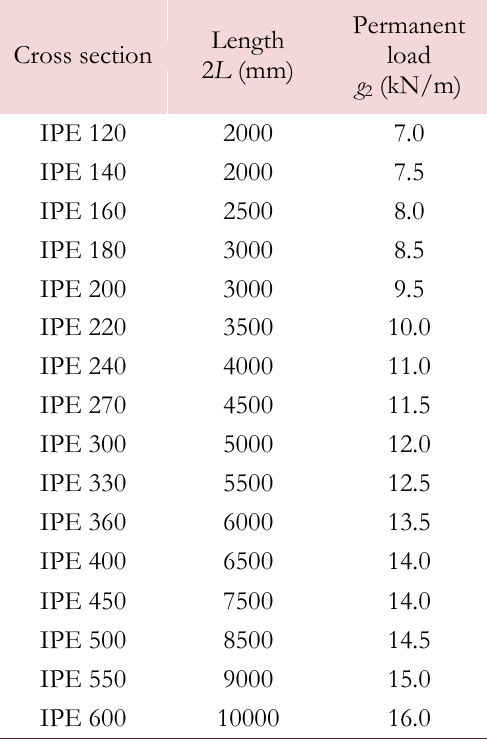
Table 2: Pre-sizing of steel